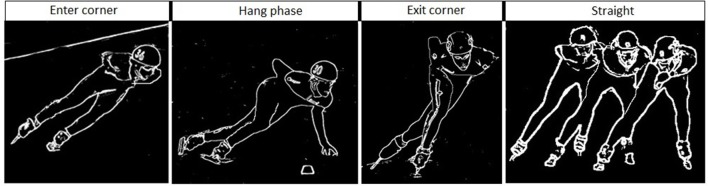
Skating at the corner (first three panels) and the straight (right panel) in short track speed skating. The corner in short-track speed skating contains three subsections in the following order: an entry at which the skater performs leg crossovers, a hang in which the skater travels around the apex of the corner supported solely on the right blade, and an exit involving leg crossovers. The straight contains in short-track speed skating a glide on each blade and ends when the left blade touches the ice after the right foot glide.